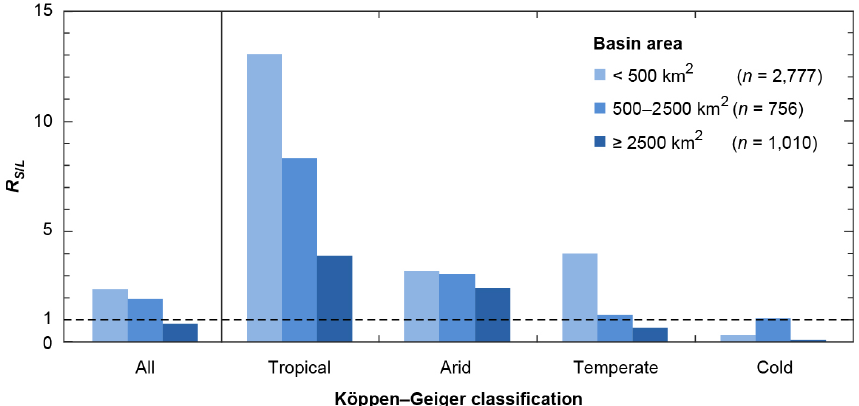
Figure 9. The ratio of short- to long-term erosion rates ( R S / L ) of each basin area bin between climate zones for the Köppen–Geiger climate classification. Each ratio was calculated from the medians of short- to long-term erosion rates of each area bin in each climate zone. The numbers of data points in each basin area bin (short-term plus long-term erosion rates) are listed in the legend. The dotted line indicates equality of short- and long-term rates. Generally, in smaller basins, short-term erosion rates tend to be higher than long-term rates compared to larger